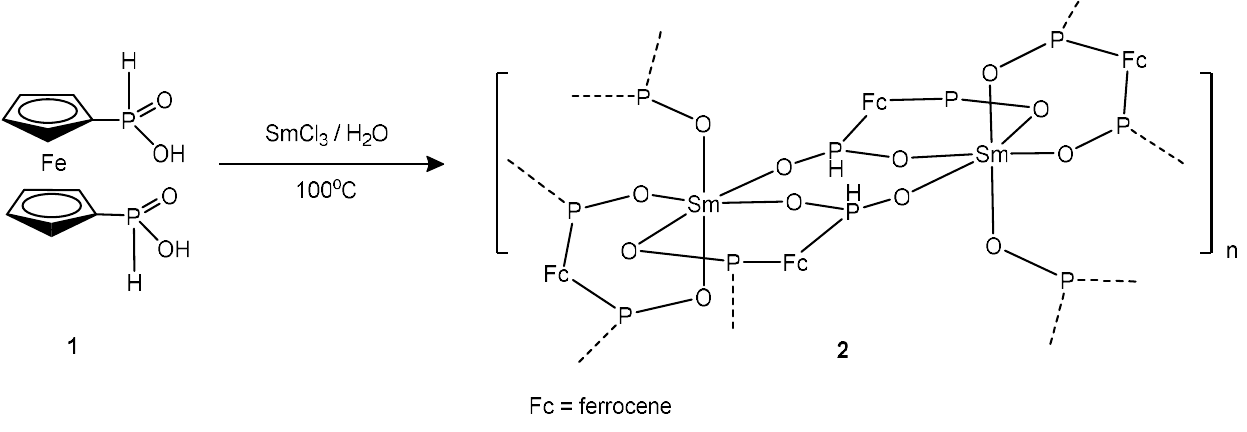
Scheme 1. Synthesis of coordination polymer 2 .